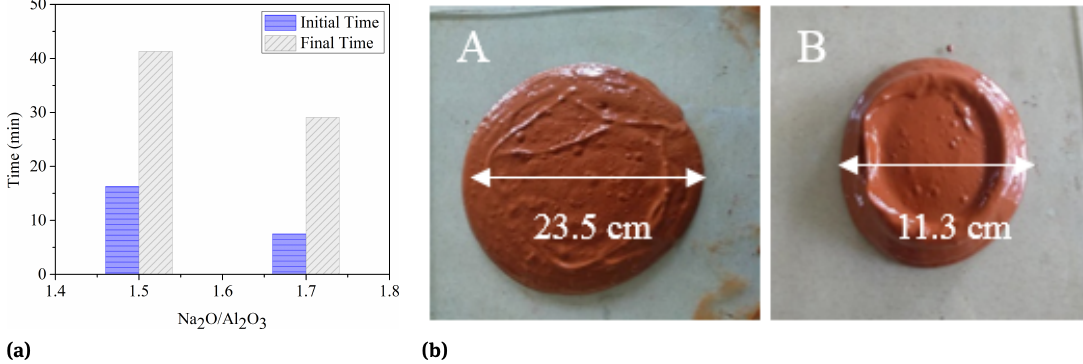
Figure 7: (A) Effect of N/A molar ratio on setting time; (B) Effect of N/A molar ratio on sample consistency (A: A1.5 and B: A1.7)